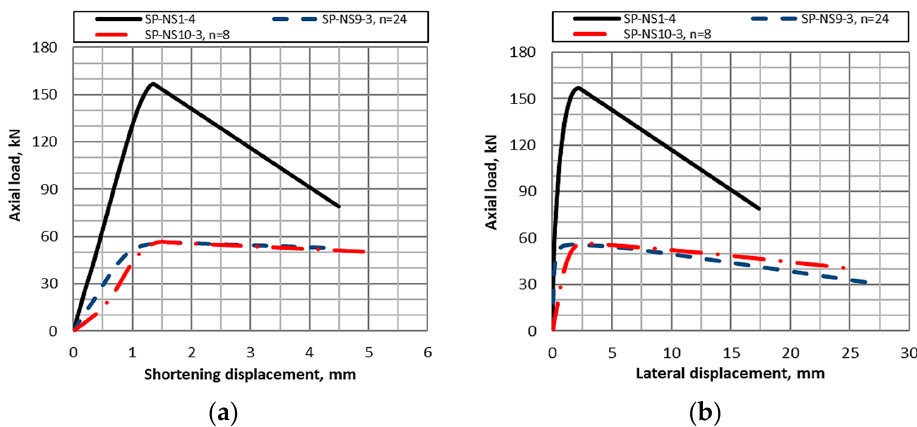
Figure 10. Axial force versus shortening ( a ) and lateral displacement ( b ) for n = 8 and 24, DoO = 42.90%.